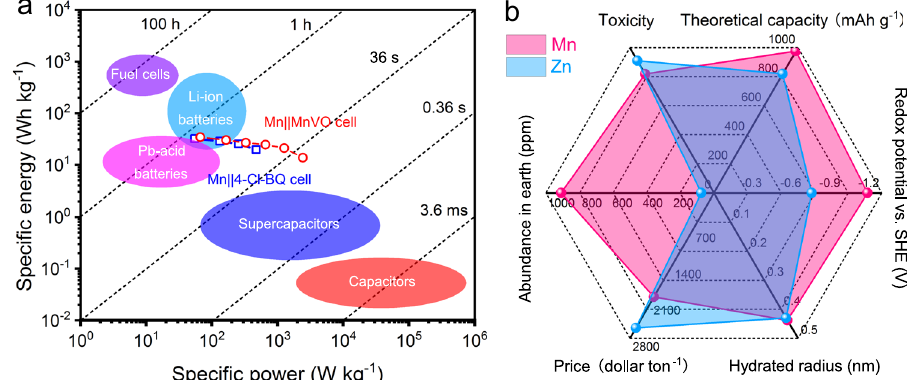
Fig. 6 Comparison of aqueous MIBs with other energy storage systems. a Ragone plot showing the speci fi c energy and power of the aqueous Mn cells with various commercial energy storage devices 60 . b Comparison of the general features between Mn and Zn 6